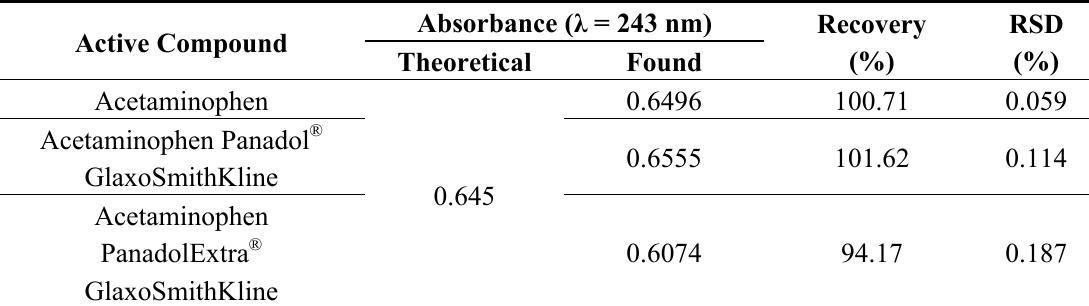
Table 4. Determination of acetaminophen by